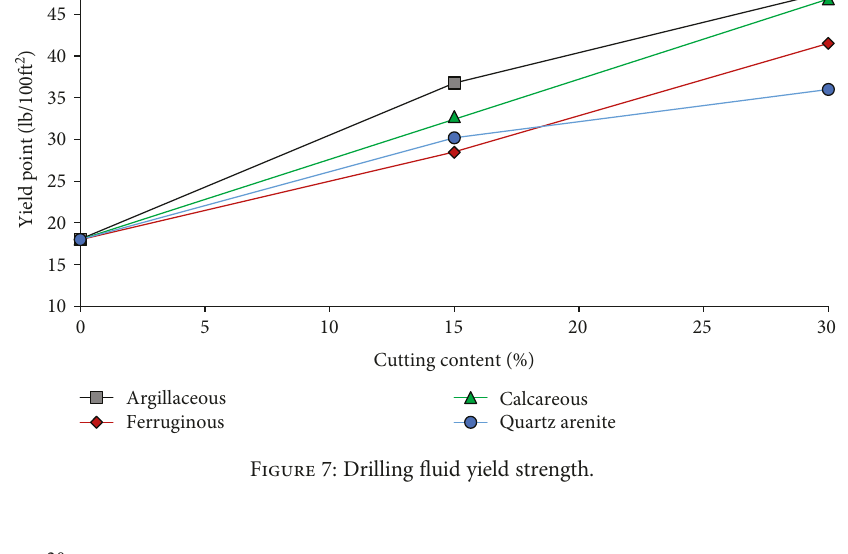
Figure 7: Drilling fl uid yield strength.